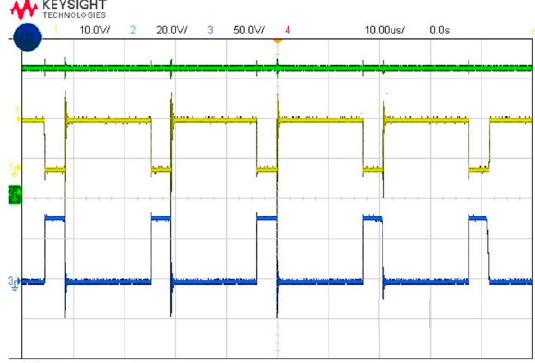
Figure 17. Wind power circuit test waveform.